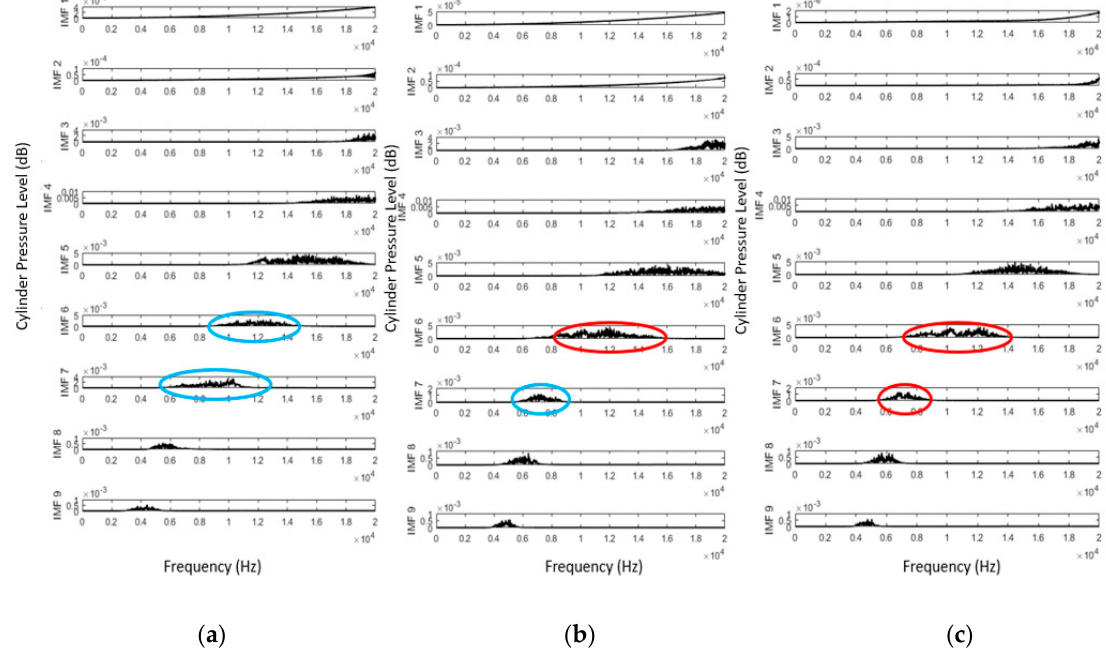
Figure 12. IMFs components of in-cylinder pressure by adaptive cyclic average TVF-EMD with di ff erent ensemble averaging time in frequency domain: ( a ) 10; ( b ) 50; ( c ) 70